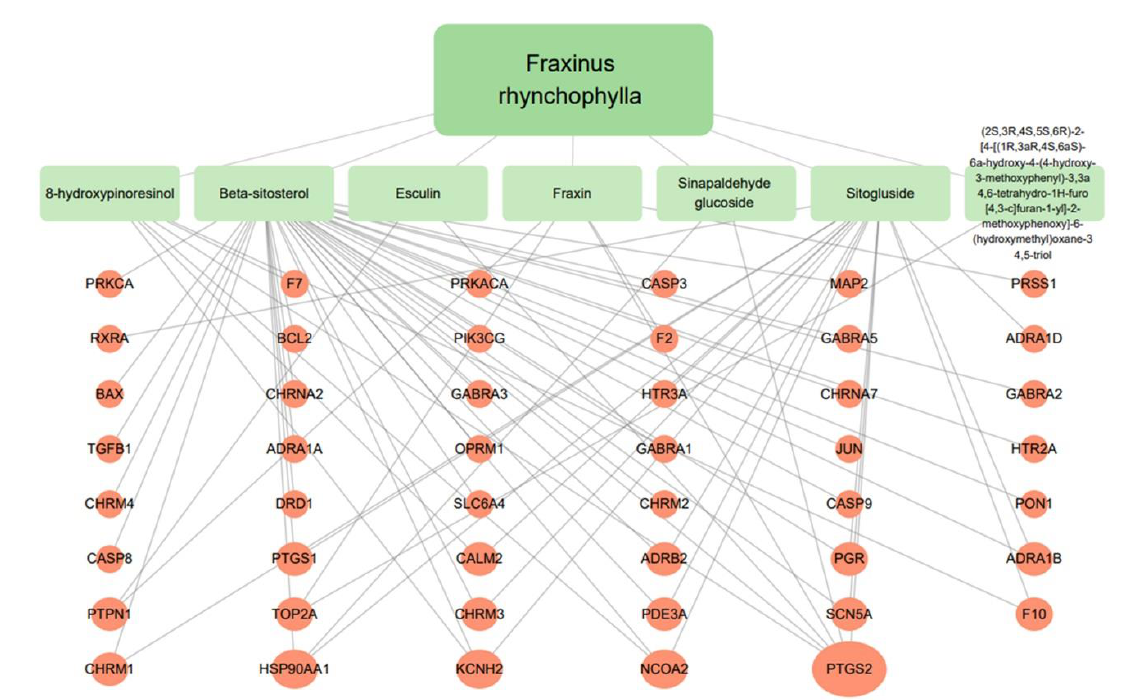
Figure 1. Seven active compounds and target genes in F. rhynchophylla . 2.3. Seven Target Genes Associated with Inflammatory Dermatosis Were Found To confirm the relationship between the seven active compounds and inflammatory- skin-disease-related genes, we searched for inflammatory dermatosis (UMLS CUI: C3875321)- related genes in the DisGeNET platform. In total, 382 genes were found, and 368 were confirmed. The remaining 14 genes were filtered out because they were not identified